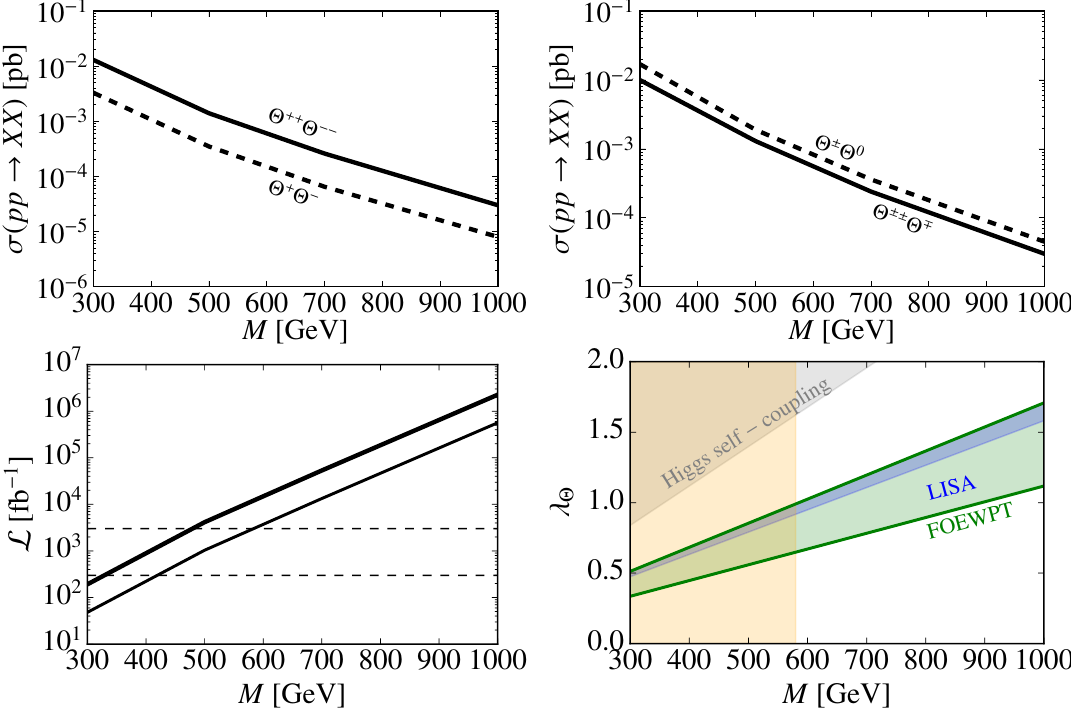
Figure 6 . Upper left) Neutral current cross sections for pair-production of scalars in the custodial quadruplet model. Upper right) Same as before but for the charged current. Bottom left) Integrated luminosity required to exclude the custodial quadruplet at the 95% C.L. for di(cid:11)erent masses using two di(cid:11)erent analyses; see text for details. Two representative values of the collected luminosity, L = 300 fb (cid:0) 1 and L = 3 ab (cid:0) 1 are also shown with dashed lines. Bottom right) Parameter space region where the FOEWPT takes place for (cid:21) 0 = ~ (cid:21) = 1 and the reach of di(cid:11)erent searches. The yellow region shows the HL-LHC reach taken from the bottom-left panel. into lower-charged states in the custodial quadruplet, which are also di(cid:14)cult to test